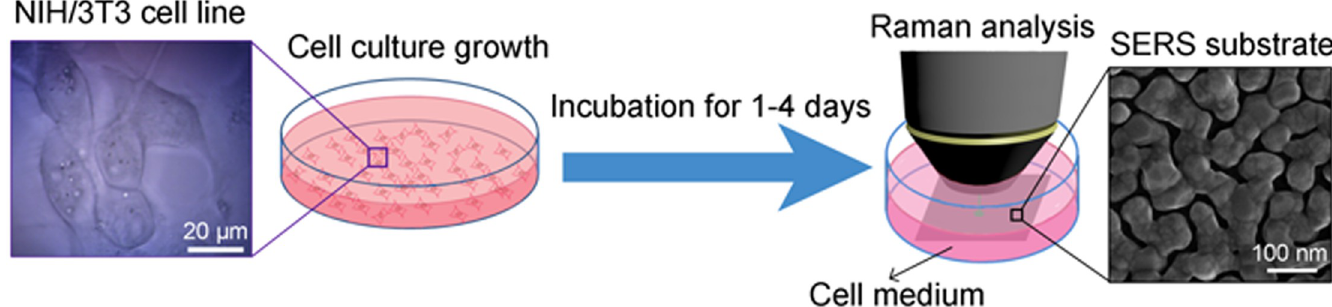
Fig 1. Schematic illustration of the experimental protocol for monitoring of extracellular metabolites. Conditionedmedium collectedfrom growing cells is analyzedby Raman spectroscopyusing Ag nanostructured substrates. In the insets: an opticalimage of NIH/3T3 cells (left) and a SEM image of a typical electroless grown Ag nanoislandpattern (right).